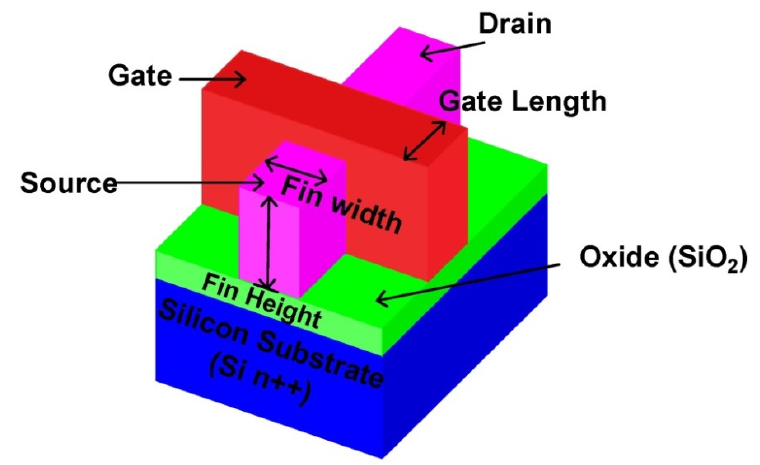
Figure 1. Three ‐ dimensional view of Silicon substrate based FinFET. Figure 1. Three-dimensional view of Silicon substrate based